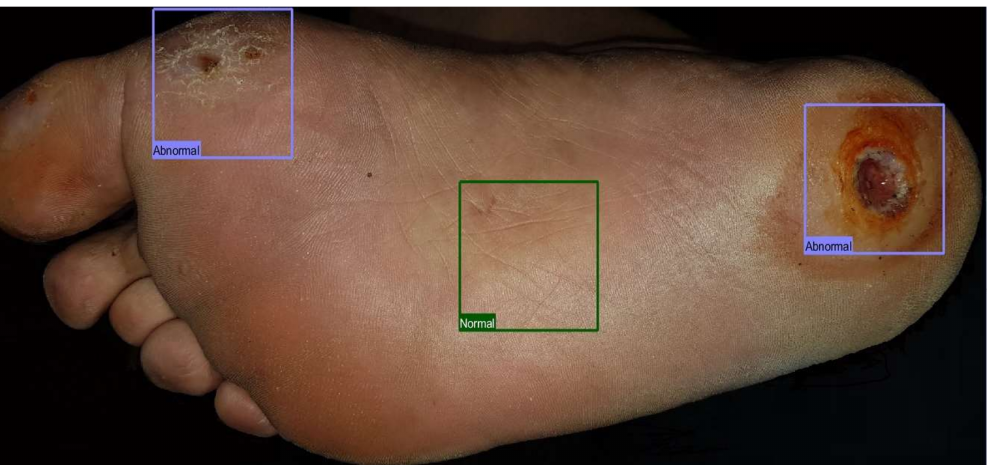
Figure 1. Sample from diabetic foot ulcer (DFU) dataset (Dataset A) of normal and abnormal region with a size of 224 × 224. The blue color is abnormal patch (DFU) class, green color is normal class. Animal Dataset (Dataset B): This dataset had 1490 images of cows (766 images) and chickens